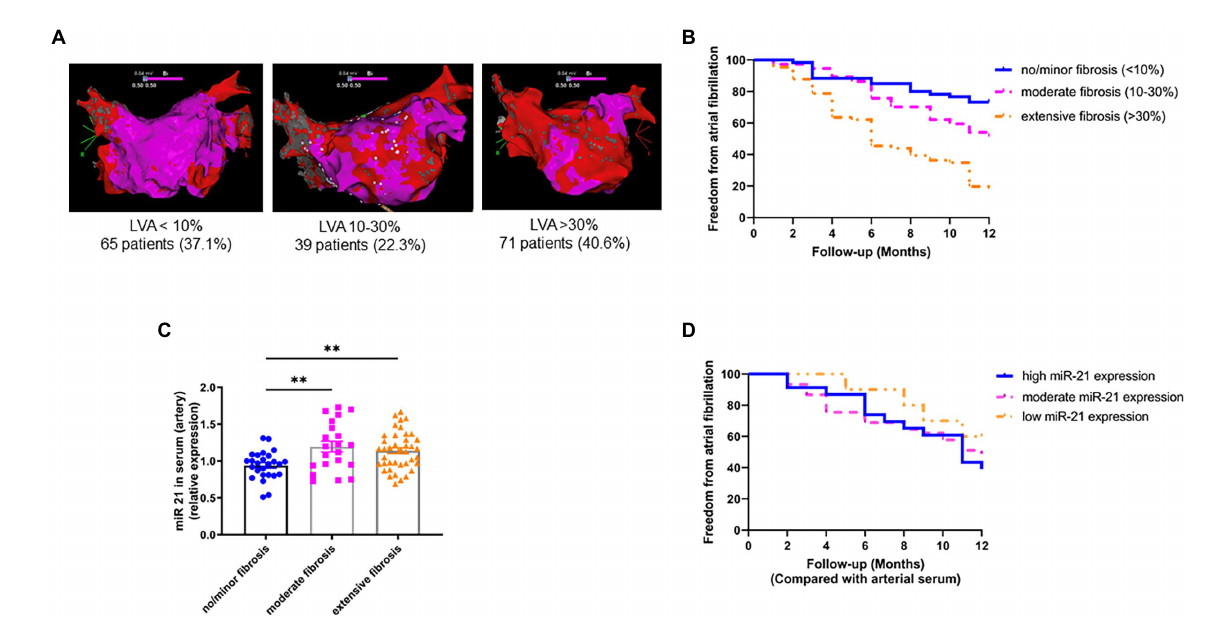
FIGURE 1 Circulating miR-21 correlates with left atrial LVAs and treatment outcome. (A) Representative high-density bipolar voltage maps from patients undergoing AF catheter ablation. No/minor LVAs: 37.1%, moderate LVAs: 22.3%, Extensive LVAs: 40.6% (semi-quantitative illustration, no scale bar available). (B) Left atrial LVAs strongly correlate with treatment outcome after ablation. Patients in SR after 12 months: 73.3% having no/minor LVAs, 51.4% having moderate LVAs and 18.2% having extensive LVAs. n = 37–66. (C) Circulating miR-21 positively correlates with left atrial LVAs. Patients with low miR-21 serum concentration had low LVAs and patients with high miR-21 had significantly more LVAs. n = 21–40. (D) Circulating miR-21 in arterial serum correlates with treatment outcome after catheter ablation. 39.1% of patients with high miR-21 serum levels were in stable SR 12 months after ablation, whereas 48.9% with moderate miR-21 concentration and 60% with low miR-21 concentration were free from AF 12 months after ablation. n = 10–45. Data are expressed as mean ± SEM. ** p < 0.01. LVAs = low voltage